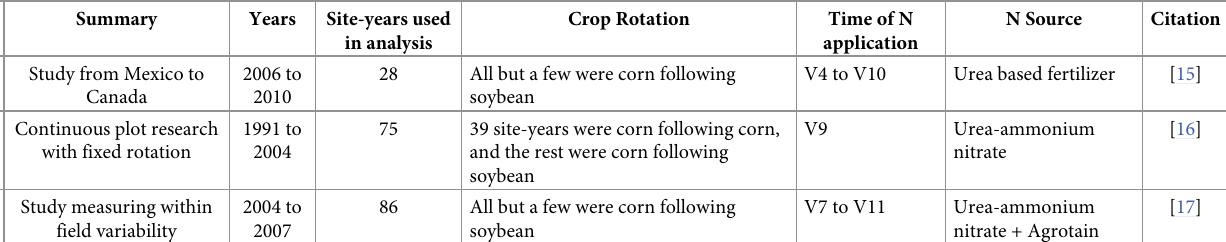
Table 1. Summary information of the three datasets used in this